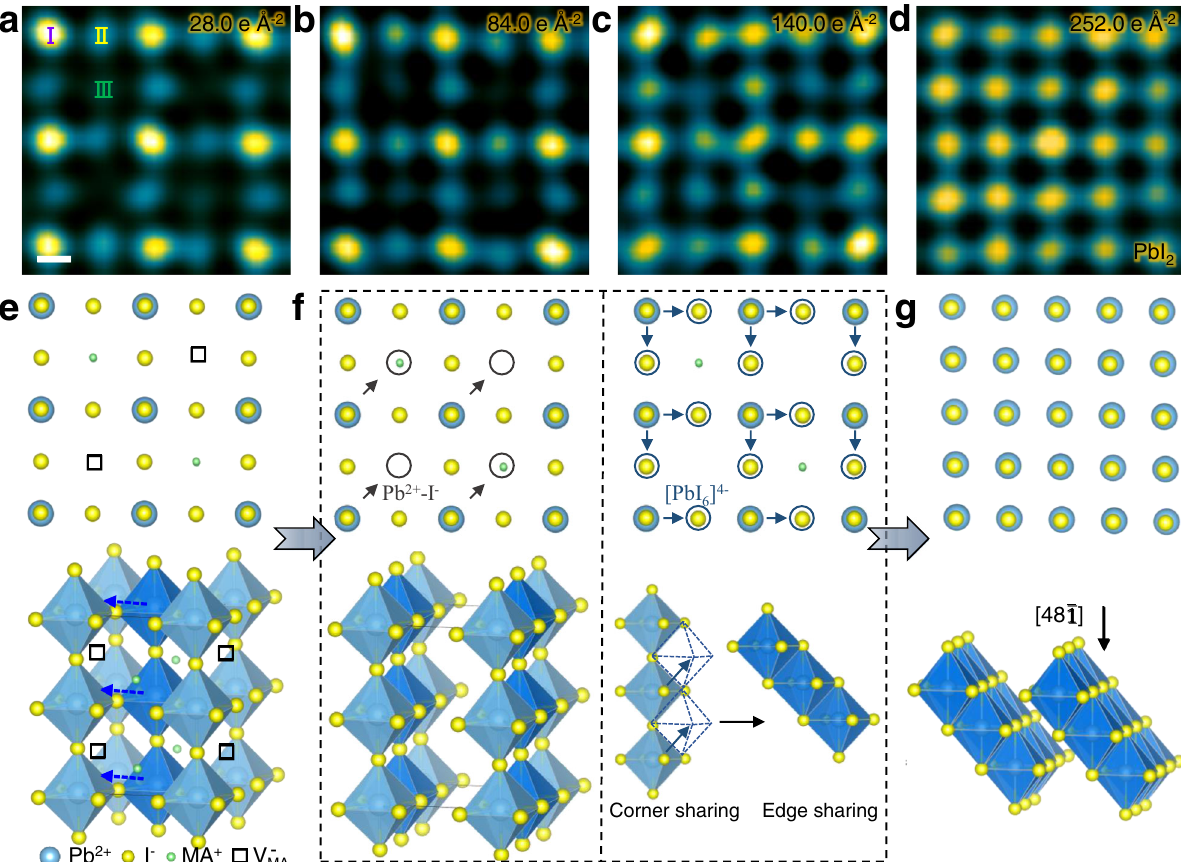
Fig. 4 Atomic-scale imaging of the decomposition pathway. a – d HRTEM images with increased doses during the degradation into PbI 2 . The corresponding doses are marked on each panel. Scale bar, 2 Å. e Atomic structure of MA 0.5 PbI 3 . Black squares indicate V (cid:1) MA. f Atomic structures to illustrate two kinds of I − and Pb 2 + diffusion. Left panel shows I − and Pb 2 + diffusing to V (cid:1) MA while the right panel illustrates the [PbI 6 ] 4 − octahedron slipping from corner sharing to edge sharing. g Atomic structure of PbI 2